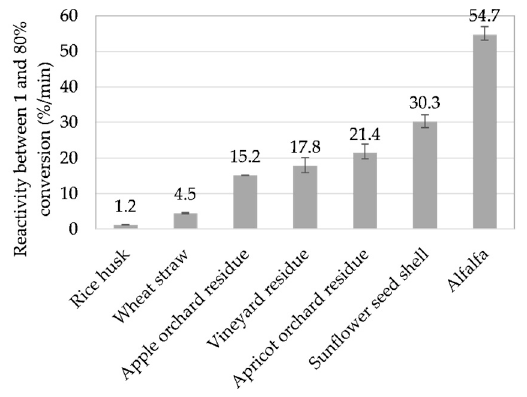
Figure 8. Gasification average reactivity between 1% and 80% conversion of biomass samples (char TGA, 0.05 L·min − 1 mixture 80 vol % N 2 /20 vol % H 2 O, 800 °C).